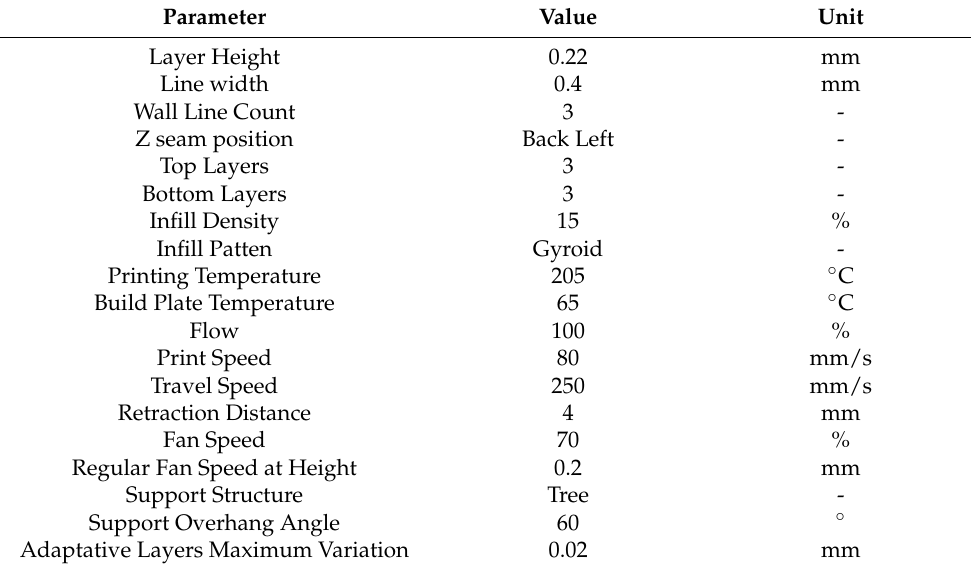
Table 1. Applied Slicing Printing Parameters in